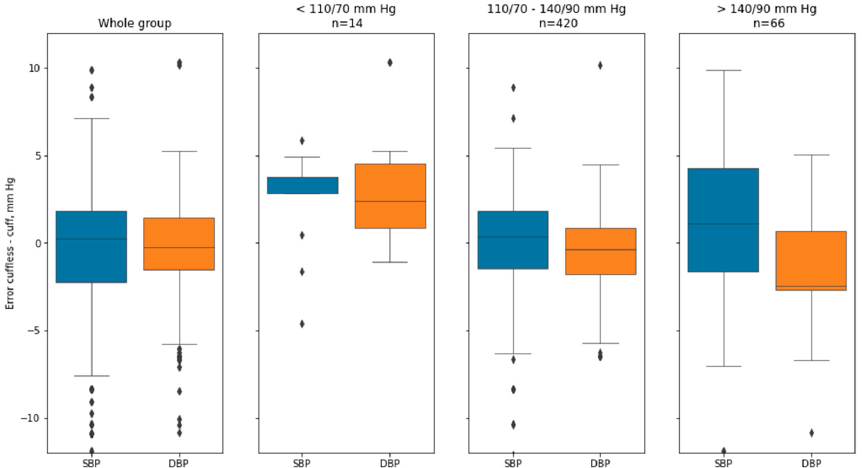
Figure 5. Bland–Altman plot of diastolic blood pressure values derived from cuff based versus cuffless measurements. At different pressure levels in patients, there were no statistically significant differences between the two methods. On average, the pressure varied by 2–4 mm Hg. (Figure 6).